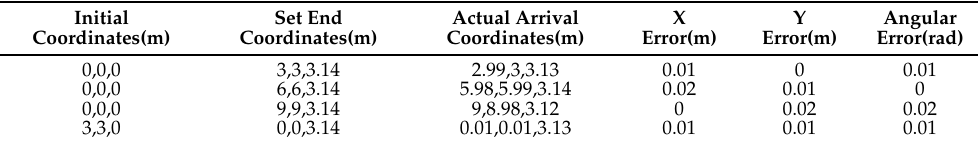
Table 3. Partial navigation